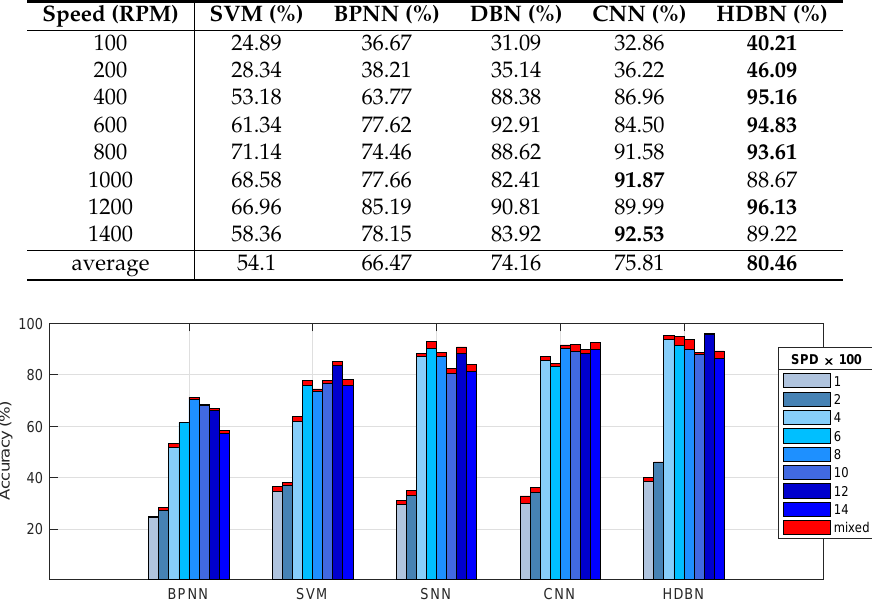
Figure 15. Recognition accuracy comparison of different models.